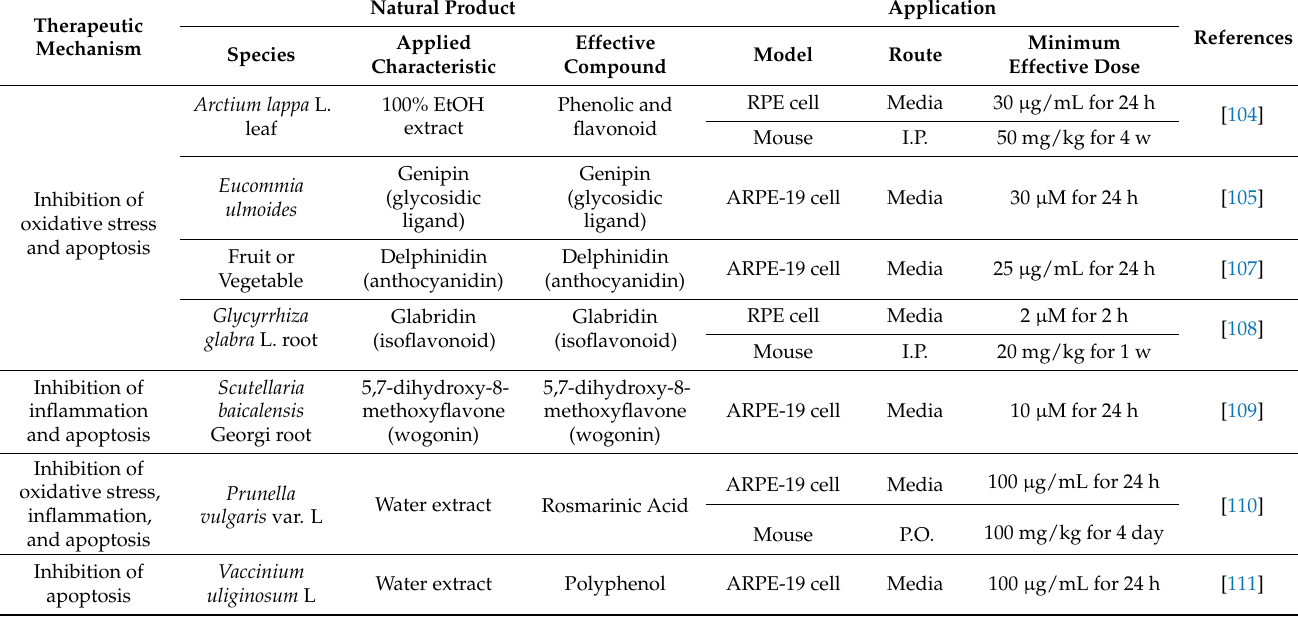
Table 7. Summary of AMD drug candidates developed from natural